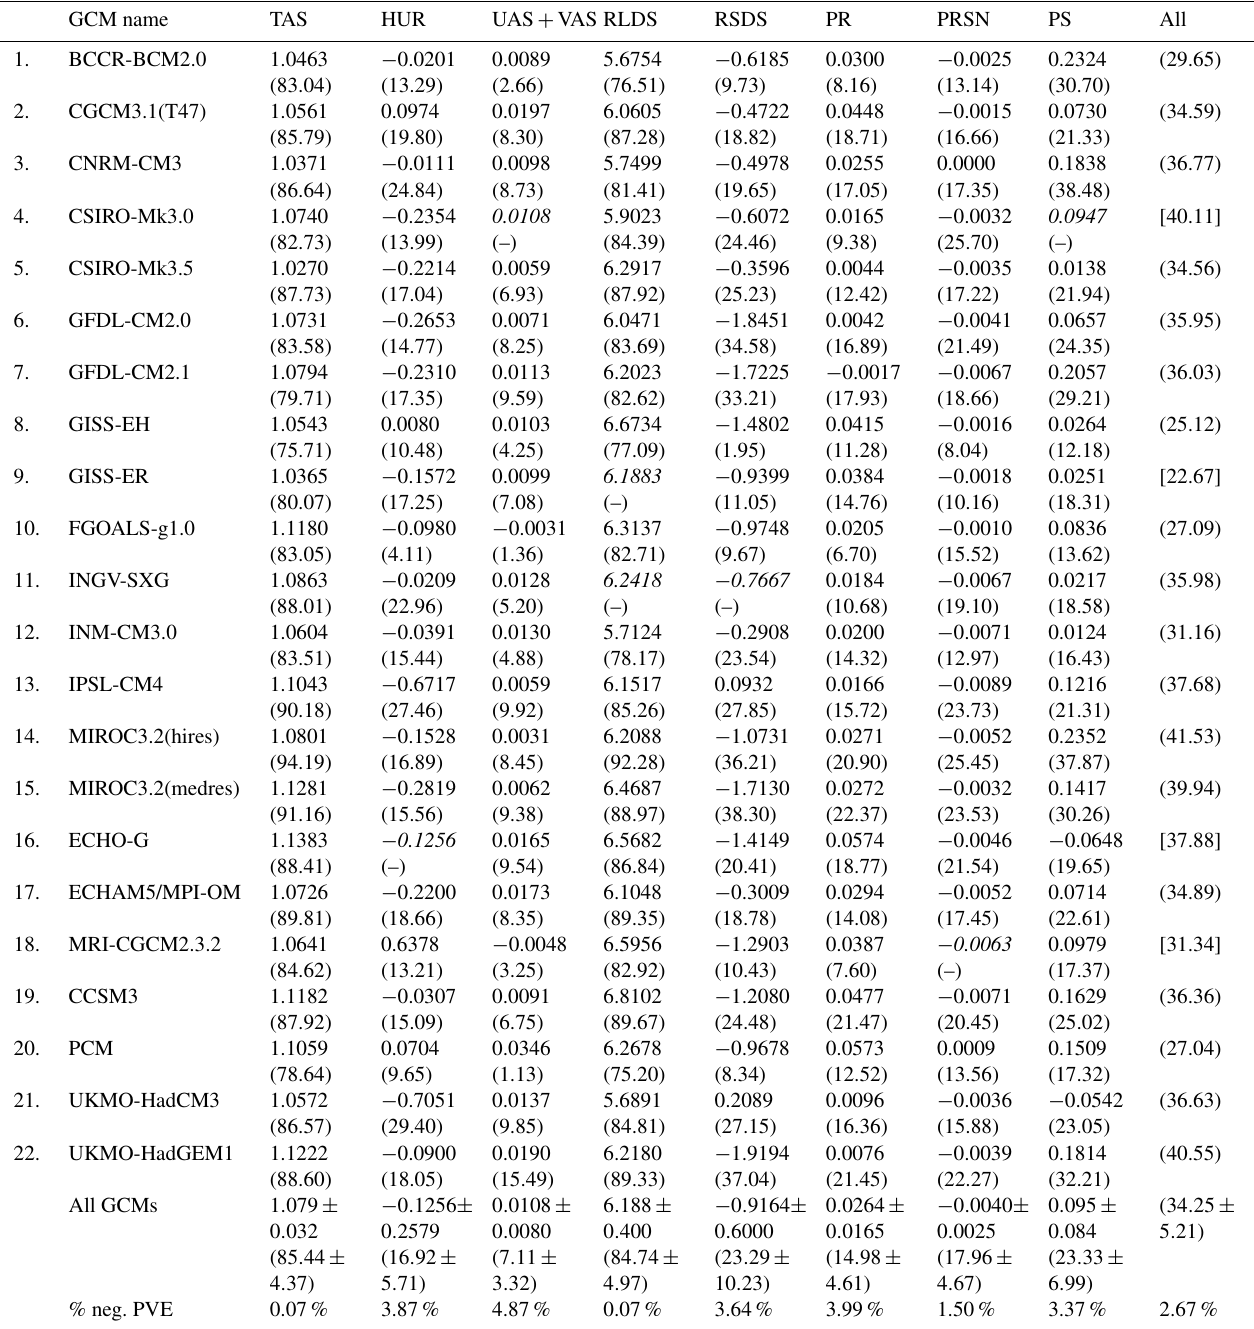
Table 3. Summary of magnitude, range and robustness of climate change patterns across variables and GCMs. In each table cell, the first value is the mean, followed by the percentage variance explained statistic (PVE, in brackets, underneath). The values in italics are across- ensemble averages used to fill in data gaps (missing variables for some GCMs). In these cases, the PVE statistic was not calculated. Square brackets in the last column denote average PVE (across variables) calculated for these incomplete sets of variables. The penultimate row (All GCMs) contains across-ensemble means of the above statistics, plus associated SDs. The last row presents an additional diagnostic of the pattern-fitting performance – percentage of negative PVE results, which indicate that the one-parameter regression line is a worse fit than the multi-decadal